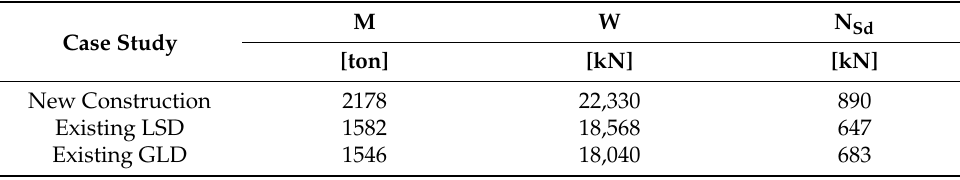
Table 1. Total mass and axial loads of archetype